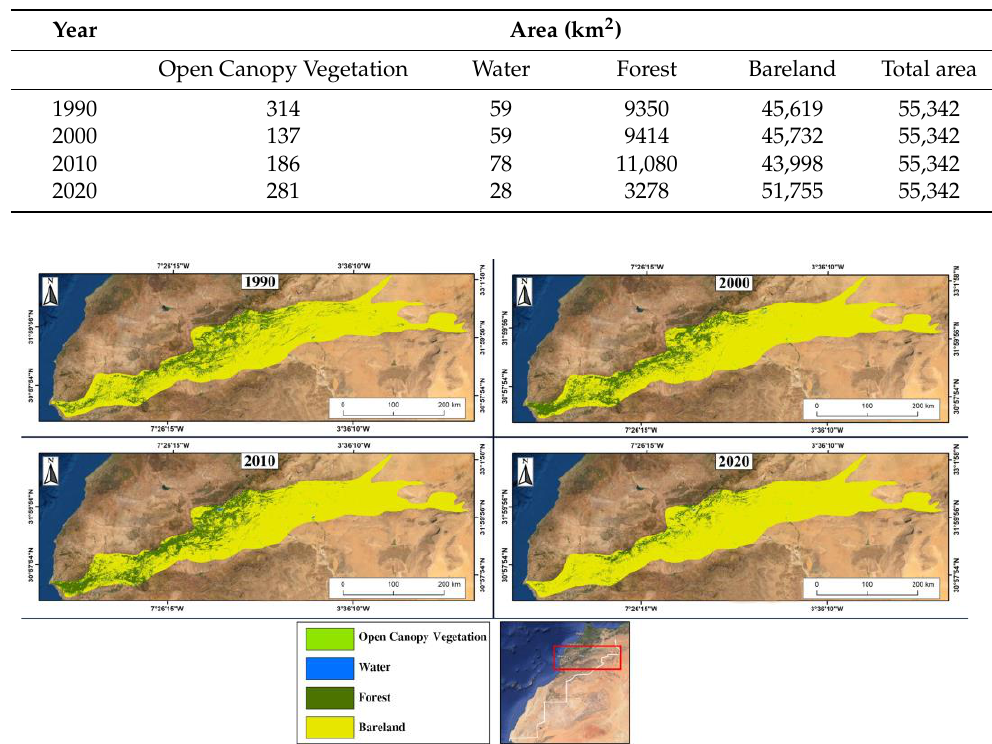
Figure 4. Land cover maps of 1990, 2000, 2010, and 2020 derived from Landsat images of the High Atlas Mountains of Morocco using the SVM method.